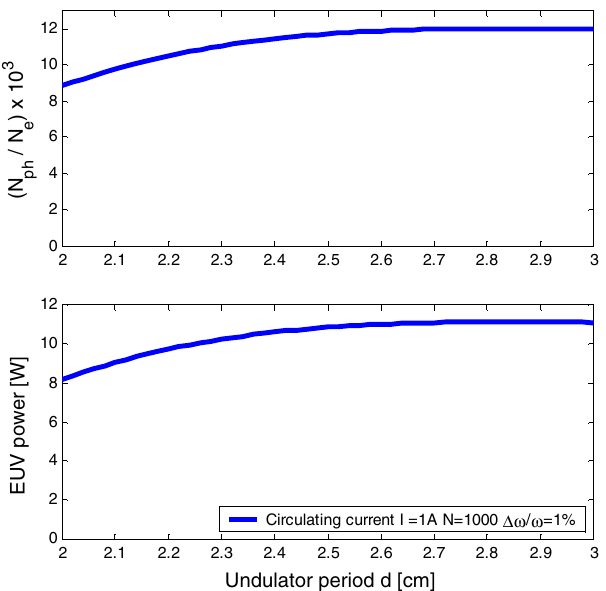
FIG. 7. EUV power of an incoherent storage-ring-based EUV source. Circulating current is 1 A, number of periods N ¼ 10 3 , and typical for EUV lithography bandwidth of 1%. The output EUV power of Watt scale is of no interest in the context of high- volume